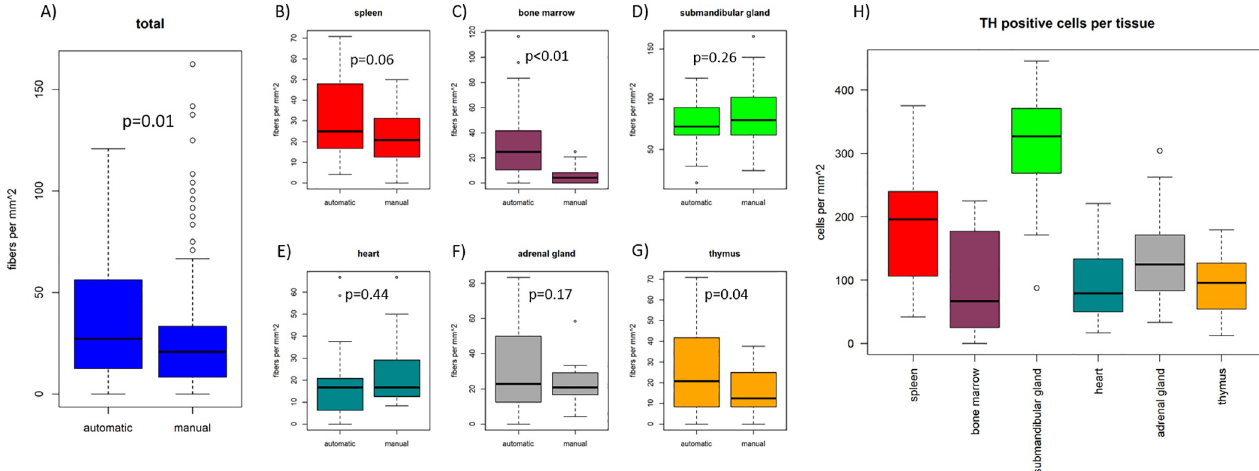
Fig 2. Fiber counts acquired by manual counting and automated approach and TH positive cells in each tissue. A) Shows the total fibers counted with both approaches. The automated approach acquires significantly more fibers than the manual method (p = 0.01). B) Fiber counts in the spleen. The automated method yields a higher fiber count than the manual approach (p = 0.06). C) in bone marrow automated counts are significantly higher than manual counts (p < 0.01). D) In submandibular gland, there is little difference between both methods (p = 0.26). E) Similar counts were acquired by both methods in heart sections (p = 0.44). F) In adrenal gland sections, both methods yield similar fiber counts (p = 0.17). G) Automated counts are significantly higher than manual counts in thymus sections (p = 0.04). P–values were determined by two-sided t–test. TH positive cells per mm 2 in each individual tissue (H)). The highest numbers of cells were counted in images of submandibular gland and spleen sections. The lowest counts were acquired in images of sections from